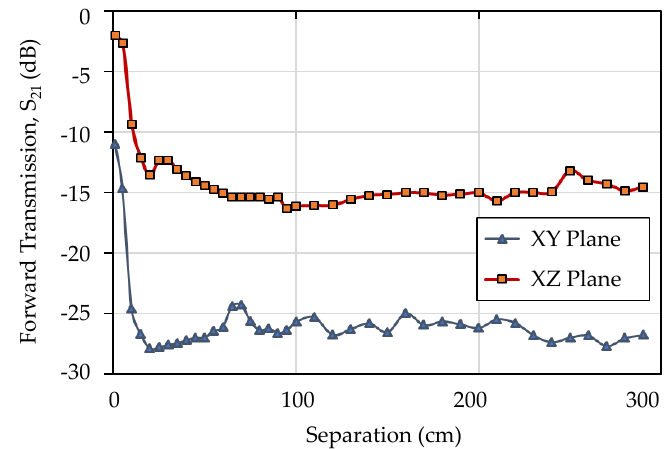
Figure 13. Measured forward transmission between the aligned (XZ plane) and misaligned (XY plane) coils, showing no dependence on the coil separation in the uncoupled